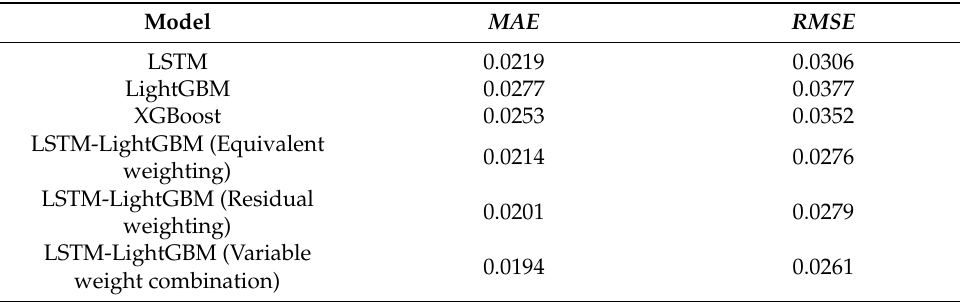
Table 2. Comparison between evaluation indexes of each